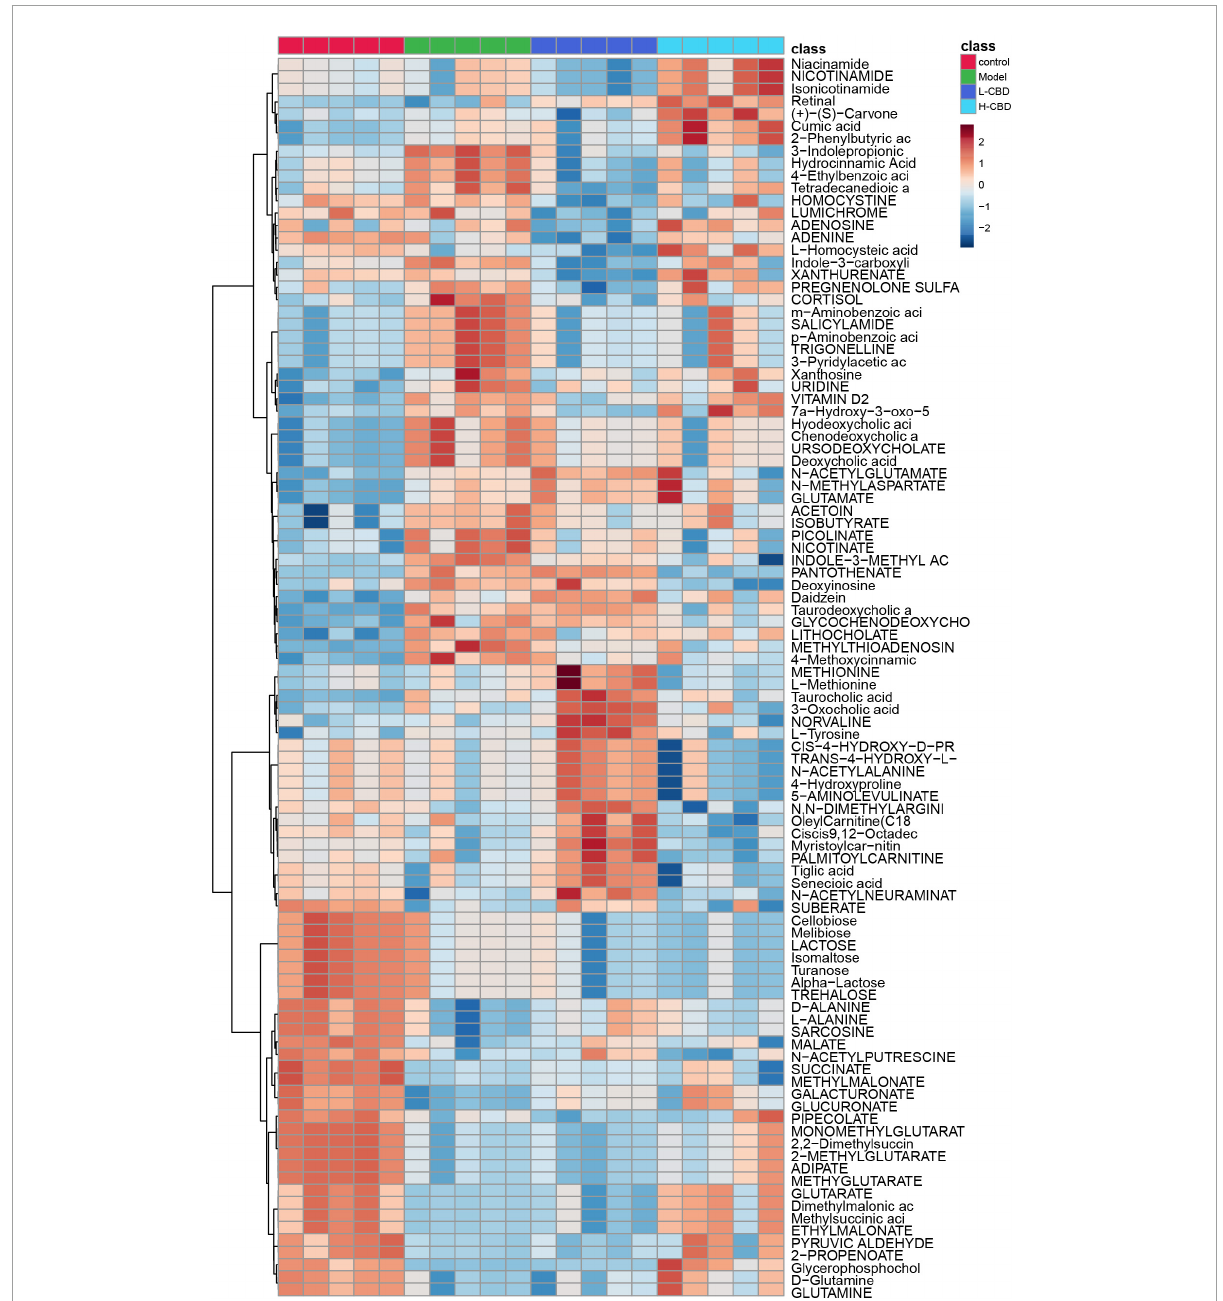
FIGURE7 Differential metabolites abundance analysis. A change from blue to red indicates an increase in the levels of